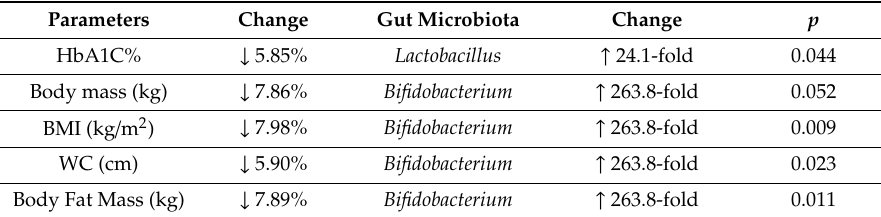
Table 4. Association between changes over time in (body composition and metabolic parameters) and changes in gut microbiota abundance in the synbiotic and placebo groups (both groups